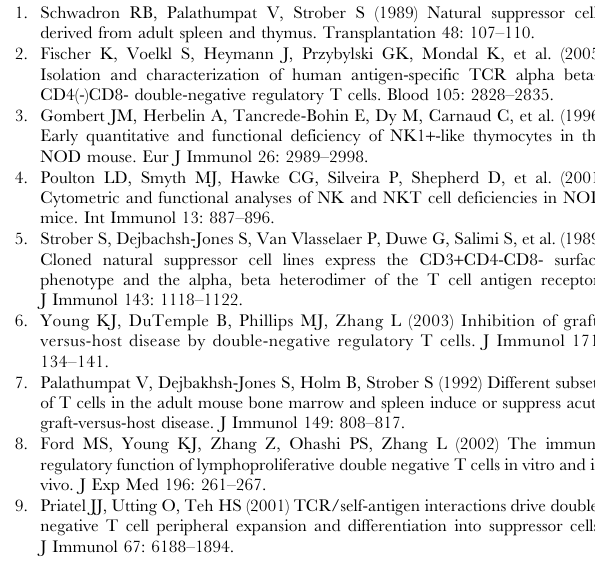
Figure S1 FACS-sorting of DNCD3 splenic cells from NOD mice. Single DNCD3 cell suspensions from the spleen of NOD and NON.NOD mice isolated from a pool of 14 day-old animals (n =20) were stained with a combination of 2 m g/10 6 cells of CD4/CD8 Ab-PE and CD3 Ab-APC conjugates. Gated-live cells ( left panel A ) were sorted for the CD3 + 4 2 8- population (P2 window) in a FACSAria instrument at 50,000 cell events/min, and re-sorted under the same conditions (P2 window in panel B ) to higher than 98% purity. Shown is one of two representative experiments. Figure S2 In Vivo cell cycle division of NOD CD4-8-TCR cd + splenic cells. A group of NOD/Scid mice (n= 6) was infused with FACS-sorted DNCD3 splenocytes (5 6 10 5 cells/mouse) isolated from 14 day-old NOD females followed by CFSE injection. Seven days later, the CFSE + cells isolated from pooled spleens of CFSE- labeled NOD/Scid recipients were stained with a combination of CD4/CD8 Ab-APC and TCR cd Ab-PE conjugates (2 m g Ab/ 10 6 cells), and the CFSE dilution factor measured within the CD4- 8-TCR cd -gated population. Shown is the majority of non dividing CD4-8- double negative TCR cd + cells (dark histogram) as compared with non dividing NOD DNCD3 control splenic cells labeled in vitro with CFSE (dotted histogram). Figure S3 In vivo proliferation of DNCD3 splenic cells from NOD mice at various time-points after birth. Groups of young NOD littermates of 2, 7, 14, and 28 days of age (n= 3 2 7 mice per group) were injected intravenously (i.v.) with 0.1 mg CFSE per gram of body weight, and seven days later the spleen cells were harvested, cells from each group were pooled, and stained with CD4 Ab-PerCP Cy5.5, CD8 Ab-PE, and CD3 Ab-APC conjugates. The cell cycle divisions of CFSE + , CD3 + 4 2 8- cells (DNCD3 cells) was determined based on CFSE dilution factor in FACS using a LSR II instrument (BD Biosciences). The number of cell cycle divisions was analyzed using the WINlist software 3D